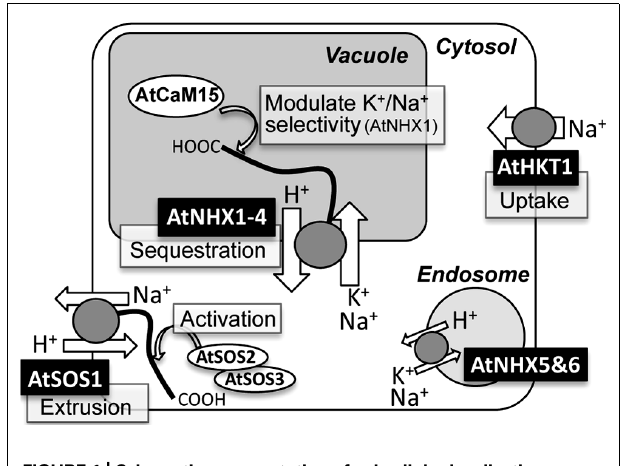
FIGURE 1 | Schematic representation of subcellular localizations, functions, and regulations of NHX-, SOS1-, and HKT1-type Na + transporters in Arabidopsis